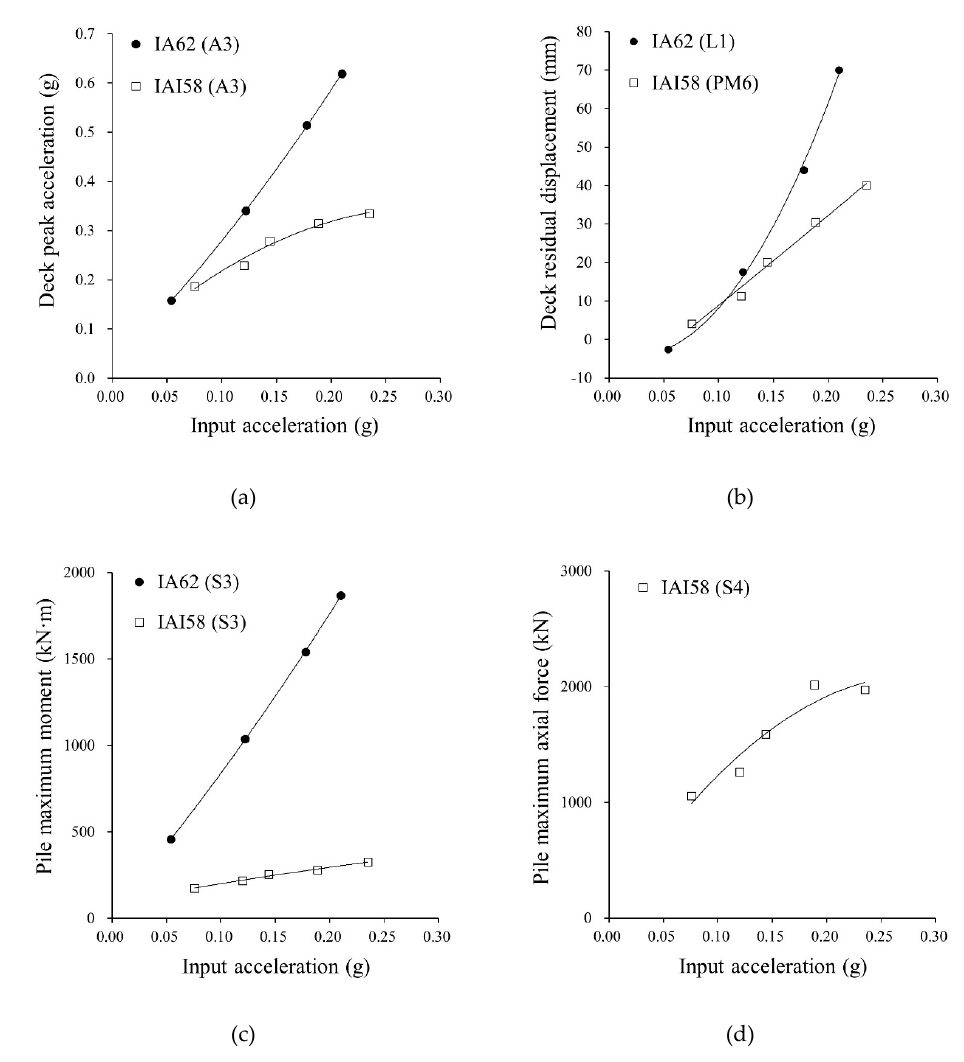
Figure 13. Response of inclined ground model corresponding to the input acceleration. (scaled to the prototype): ( a ) peak acceleration of deck plate; ( b ) horizontal residual displacement of deck plate; ( c ) maximum moment of vertical pile; and ( d ) maximum axial force of batter pile.